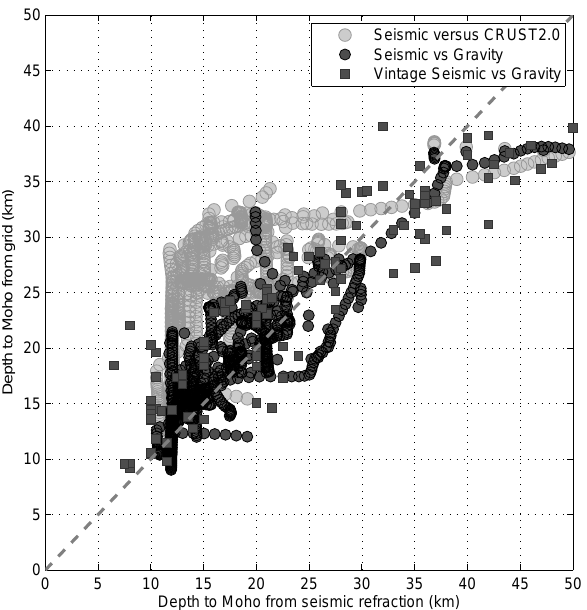
Fig. 9. Comparison of depth to Moho between independent seis- mic interpretations presented in Fig. 1, a global crustal thick- ness map (CRUST2 model) (Bassin et al., 2000) and our com- puted crustal thickness from gravity inversion. Dark-grey circles show seismic depths versus gravity-inversion-derived Moho depths. Squares show the Moho depths from pre-2000 seismic studies ver- sus gravity depth. Light-grey circles show seismic depths versus CRUST2 model depths. Depths from CRUST2 model are typically deeper compared to regional seismic data. The grey dashed line is a 1 : 1 trend.